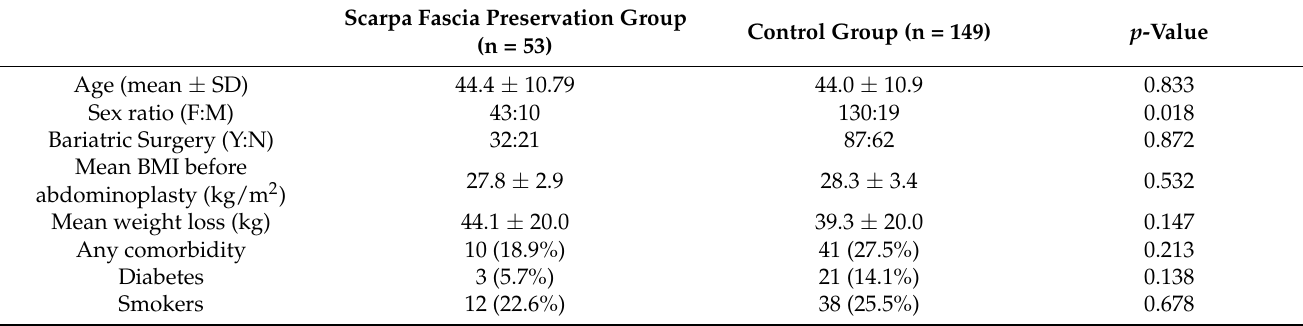
Table 1. Demographics of patients at the time of the study.